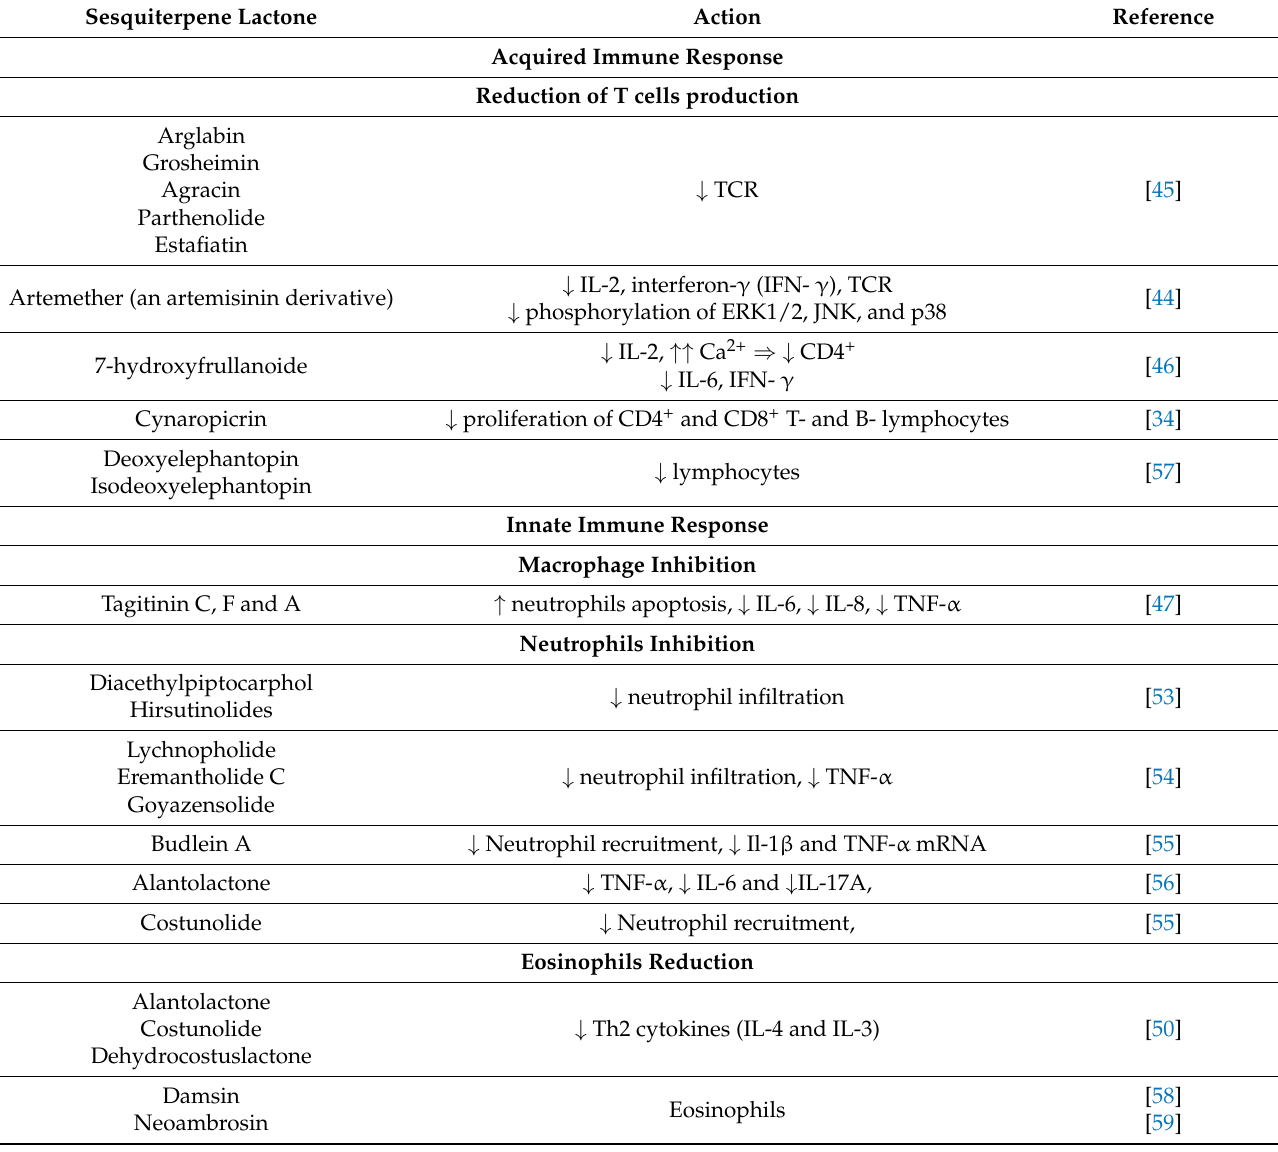
Table 1. SL described as having regulatory functions upon the immune system, highlighting im- munoregulatory actions within acquired and innate